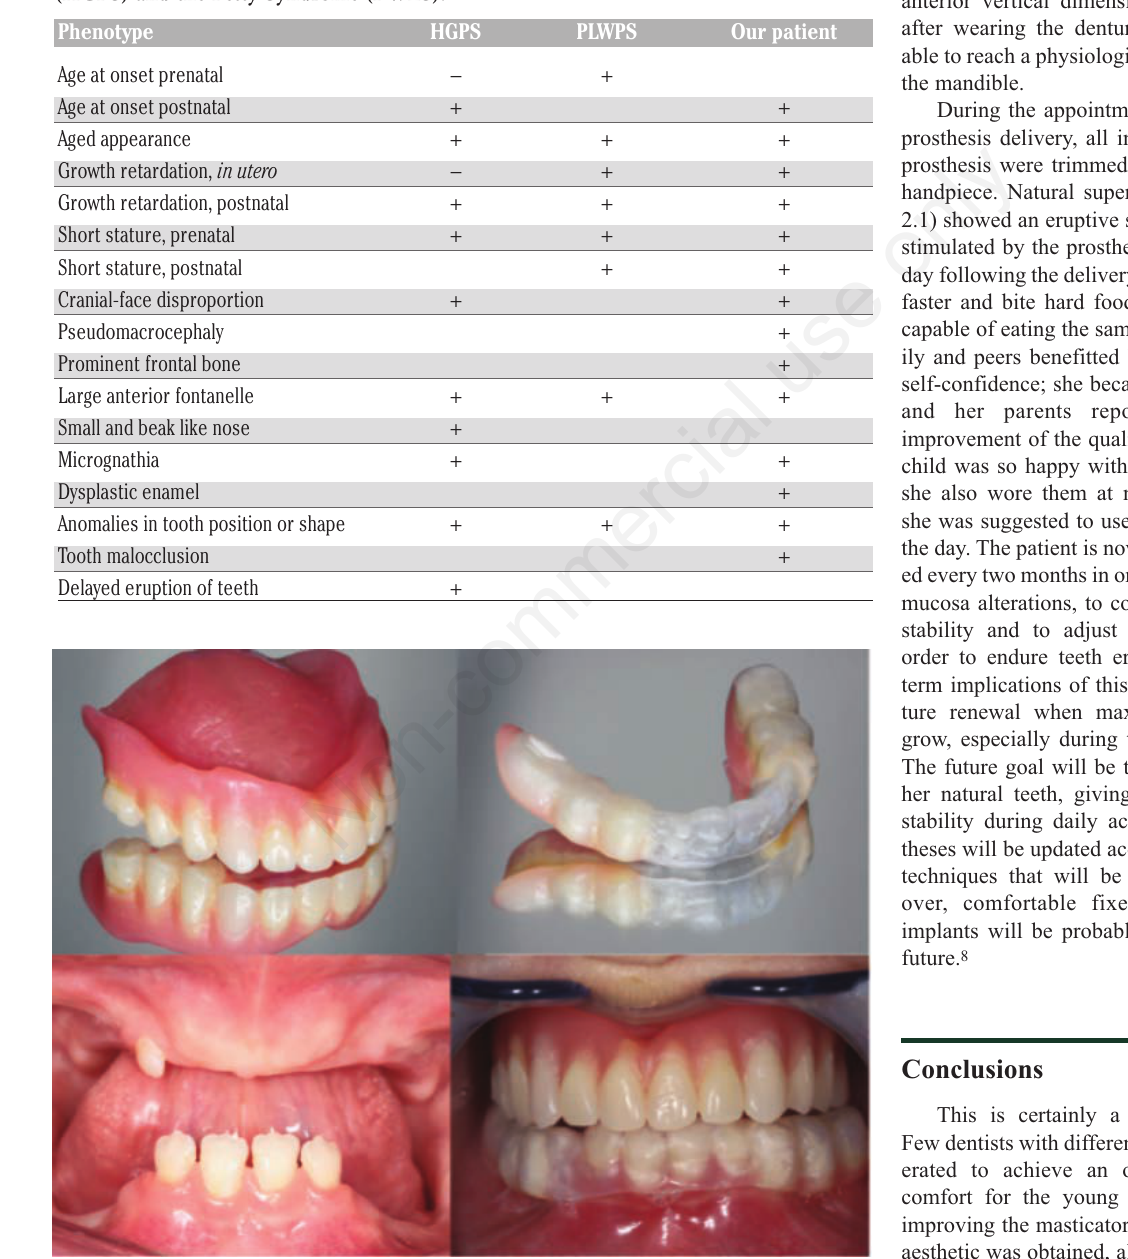
Table 1. Patient features compared to the Hutchinson-Gilford Progeria Syndrome (HGPS) and the Petty Syndrome (PWLS).